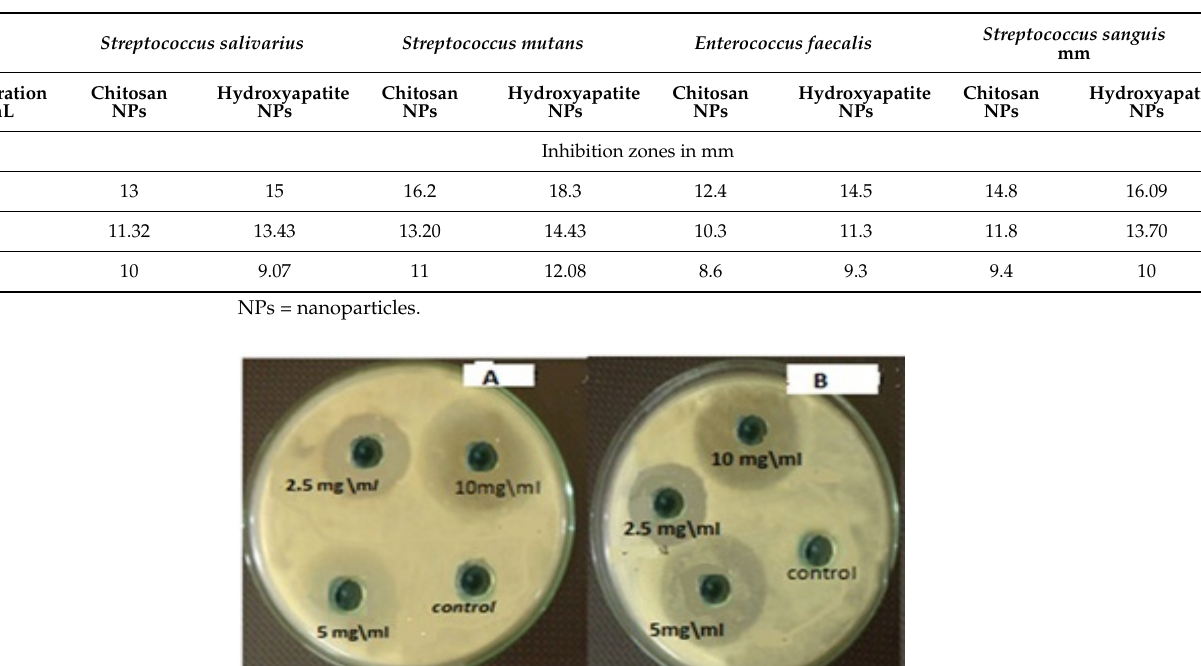
Table 1. The diameters of inhibition zones in mm of chitosan and hydroxyapatite nanoparticles against oral microorganisms.